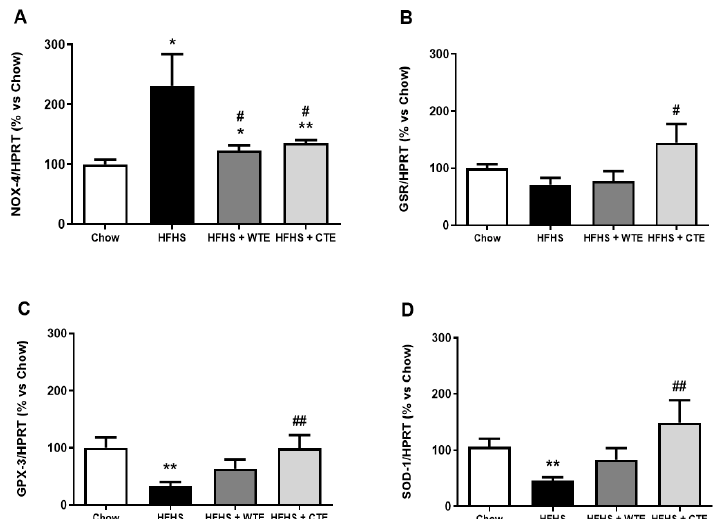
Figure 8. Gene expression of NADPH oxidase-4 (NOX-4) ( A ), glutathione reductase (GSR) ( B ), glutathione peroxidase 3 (GPX 3 ) ( C ), and superoxide dismutase-1 (SOD-1) ( D ) of mice fed a standard diet (Chow), a high-fat diet/sucrose diet (HFHS), high-fat diet/sucrose diet supplemented with White Tea Extract (HFHS+WTE), or high-fat diet/sucrose diet supplemented with Tea Complex Ex- tract (HFHS+TCE). * p < 0.05; ** p < 0.01 vs. chow. # p < 0.05; ## p < 0.01 vs. HFHS. The values are represented as the mean ± S.E.M (n = 7-10 samples/experimental group), and are expressed as a percentage vs. chow. Obesity was associated with an upregulation in the gene expression of IL-1 β ( p < 0.05), IL-6 ( p < 0.01) and NOX-4 ( p < 0.05), and with a downregulation in the mRNA levels of the antioxidant enzymes GPX-3 and SOD-1 ( p < 0.01 for both) in aortic tissue. Supple- mentation with WTE prevented the obesity-induced changes in the gene expression of IL- 1 β , IL-6 and NOX-4 ( p < 0.05 for all). Moreover, supplementation with CTE not only de- creased the mRNA levels of IL-1 β ( p < 0.001), IL-6 ( p < 0.01) and NOX-4 ( p < 0.05) in arterial tissue, but also increased the gene expression of the antioxidant enzymes GPX-3 and SOD- 1 ( p < 0.01 for both). Likewise, supplementation with WFTE and CTE reduced the obesity-induced in- crease in the content of superoxide anions in the aorta sections (Figure 9; p < 0.05 for both). Indeed, the content of this free radical was significantly lower in aorta sections from mice supplemented with the extracts than in the control animals ( p < 0.05 for both).